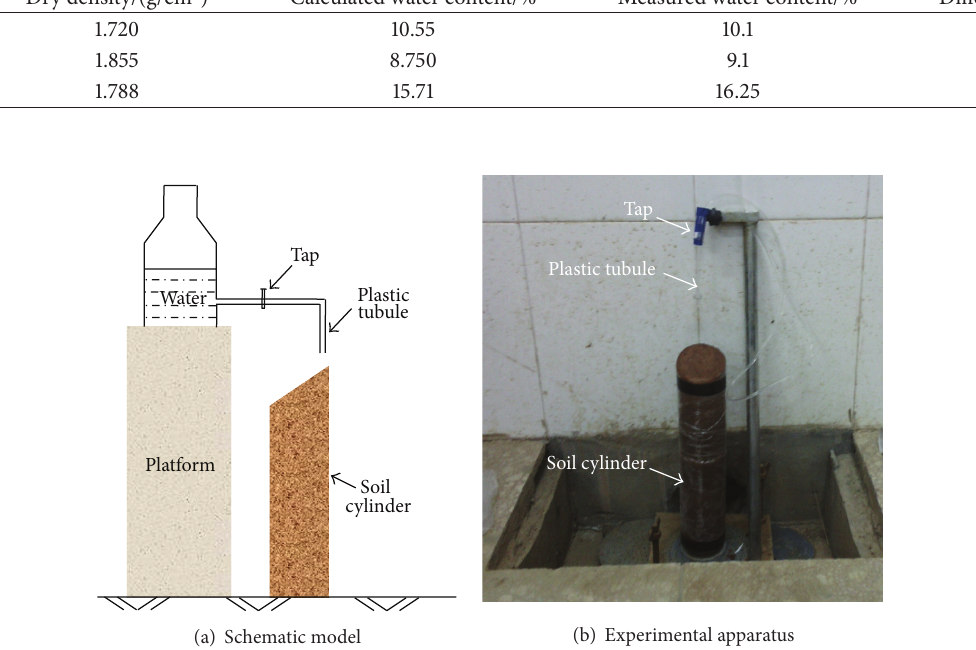
Figure 3: Rainfall simulation test on red clay cylinder